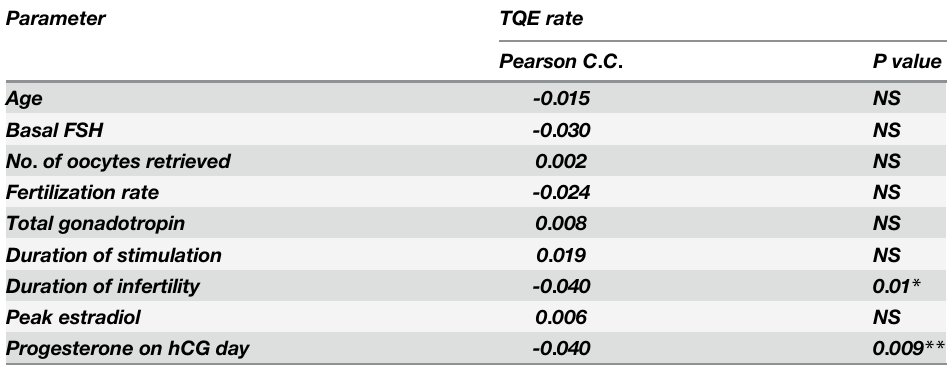
Pearson C . C . P value NS -0 . 024 0 . 009 **